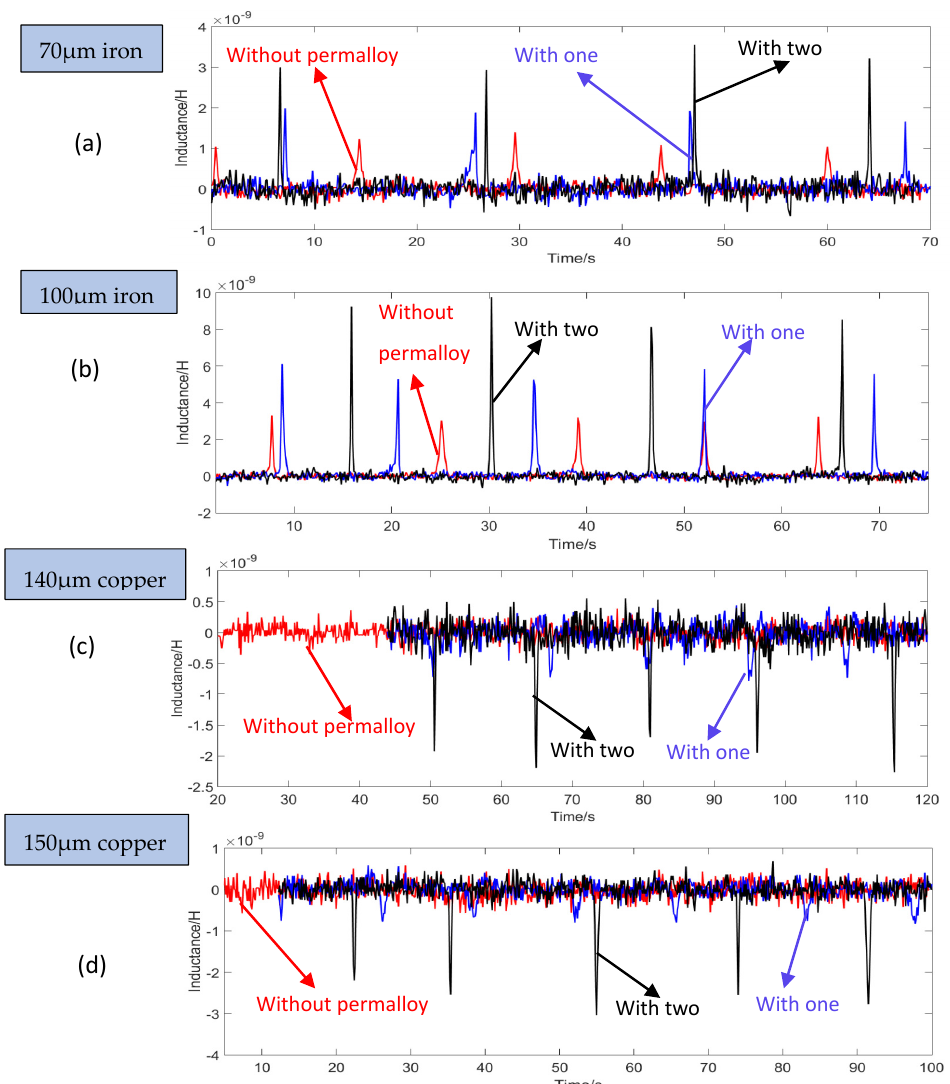
Figure 9. Signal value comparison: ( a ) 70 μ m iron particles; ( b ) 100 μ m iron particles; ( c ) 140 μ m copper particles; ( d ) 150 μ m copper particles.